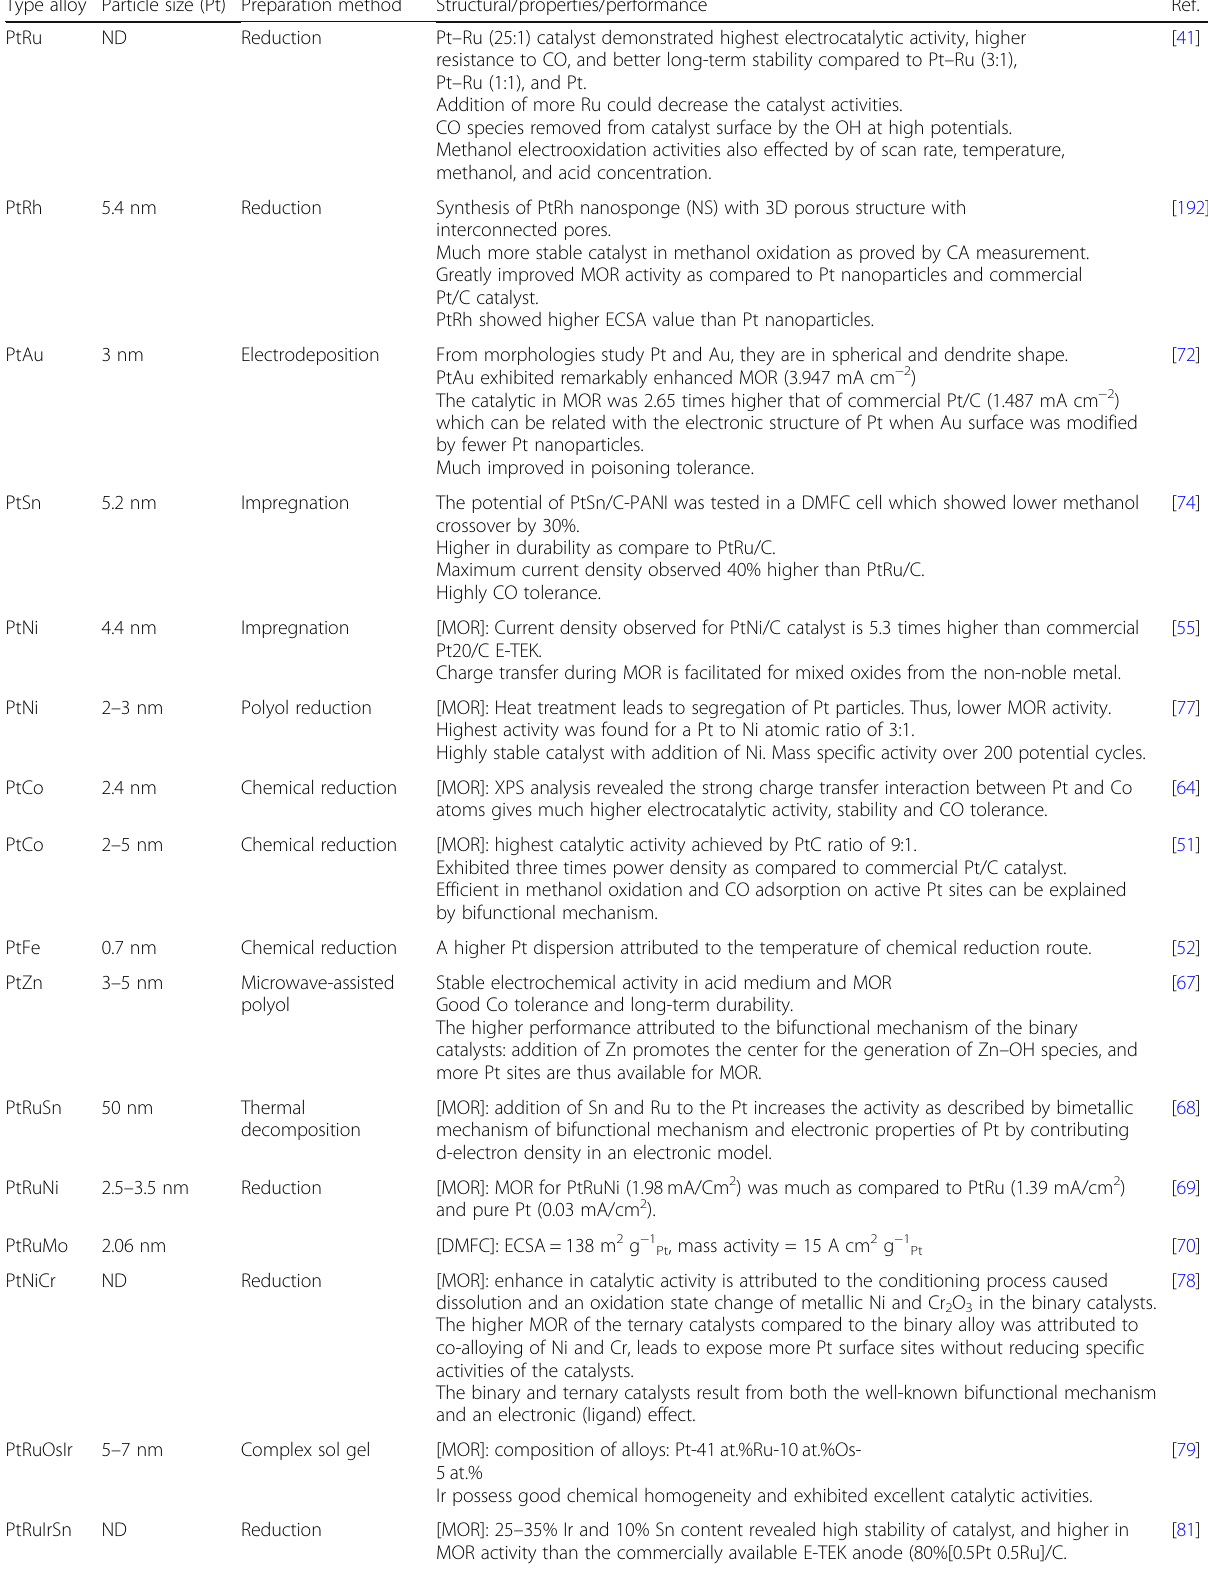
Table 1 Various type of Pt bimetallic, tertiary, and quaternary metal alloys and their performance Type alloy Particle size (Pt) Preparation method